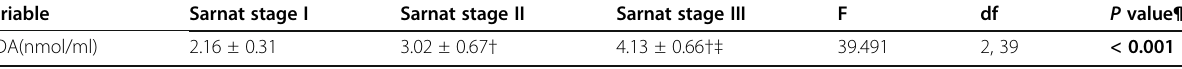
Table 2 Relation between MDA and Sarnat scores shows that the mean MDA levels were 2.16 ± 0.31 μ mol/l, 3.02 ± 0.67 † μ mol/l, and 4.13 ± 0.66 †‡ μ mol/l regarding Sarnat stages I, II, and III, respectively, in hypoxic neonates with highly statistical significant difference ( P < 0.001